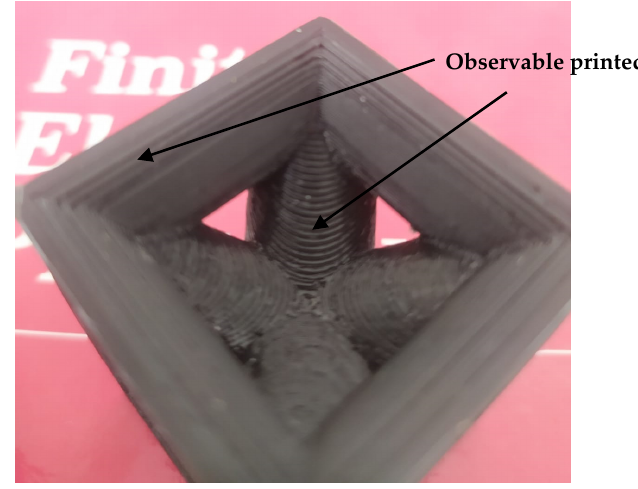
Figure 1. Stair-step effect.